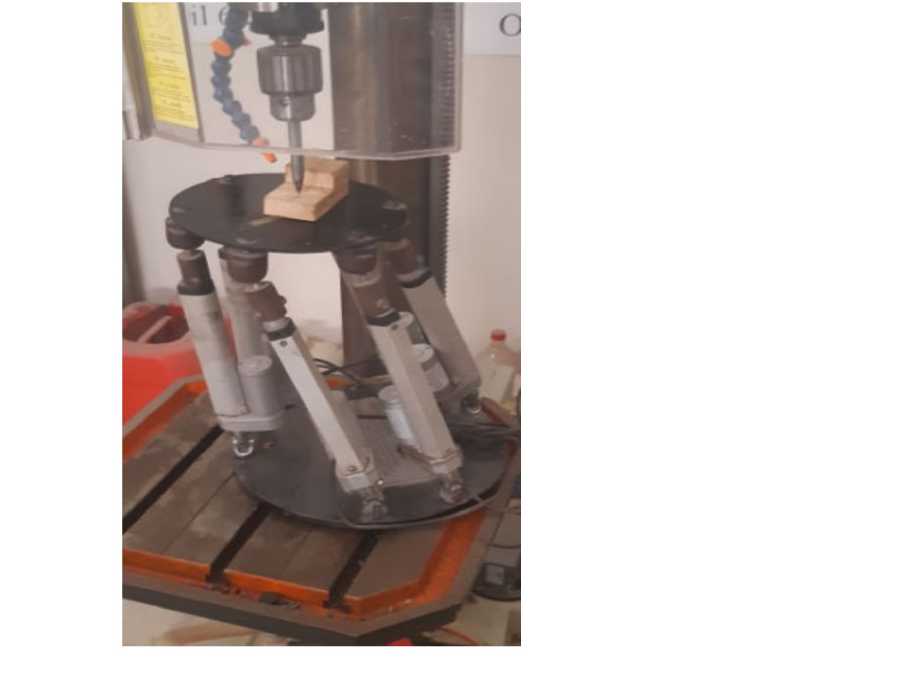
Figure 16. Experimental setup. (A pictorial view of the test being carried out by machining bed on a